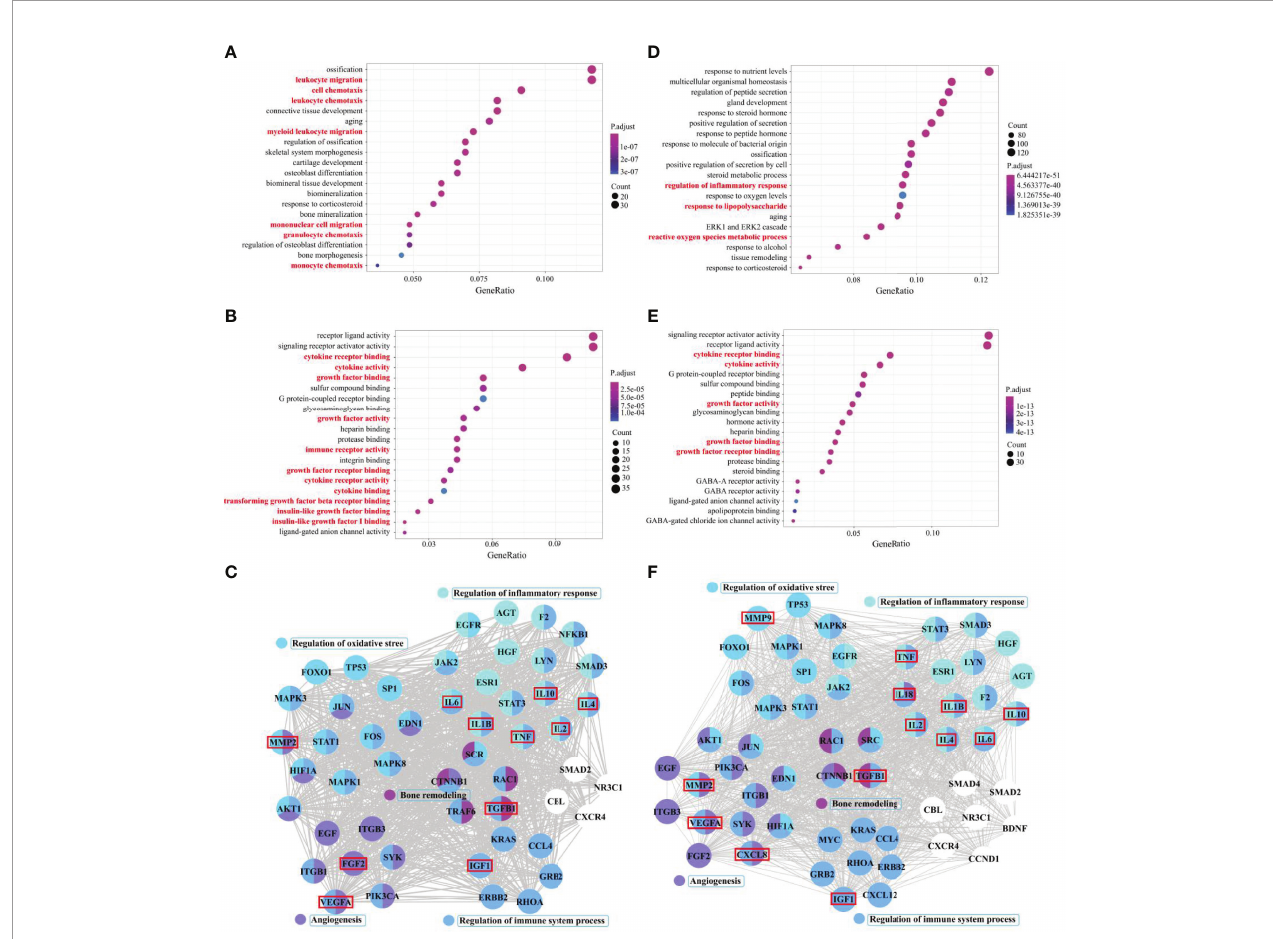
FIGURE 2 | Core cytokine networks of pathological crosstalk in postmenopausal osteoporosis (PMOP) vs. rheumatoid arthritis (RA) and PMOP vs. Alzheimer ’ s disease (AD). Gene ontology functional enrichment analysis of common differential genes in PMOP vs. RA and PMOP vs. AD was performed, including biological processes (A, D) and molecular functions (B, E) . Protein – protein interaction (PPI) network topology analysis was performed for common differential genes in PMOP vs. RA and PMOP vs. AD, and biological process enrichment analysis of core network genes was completed (C, F)